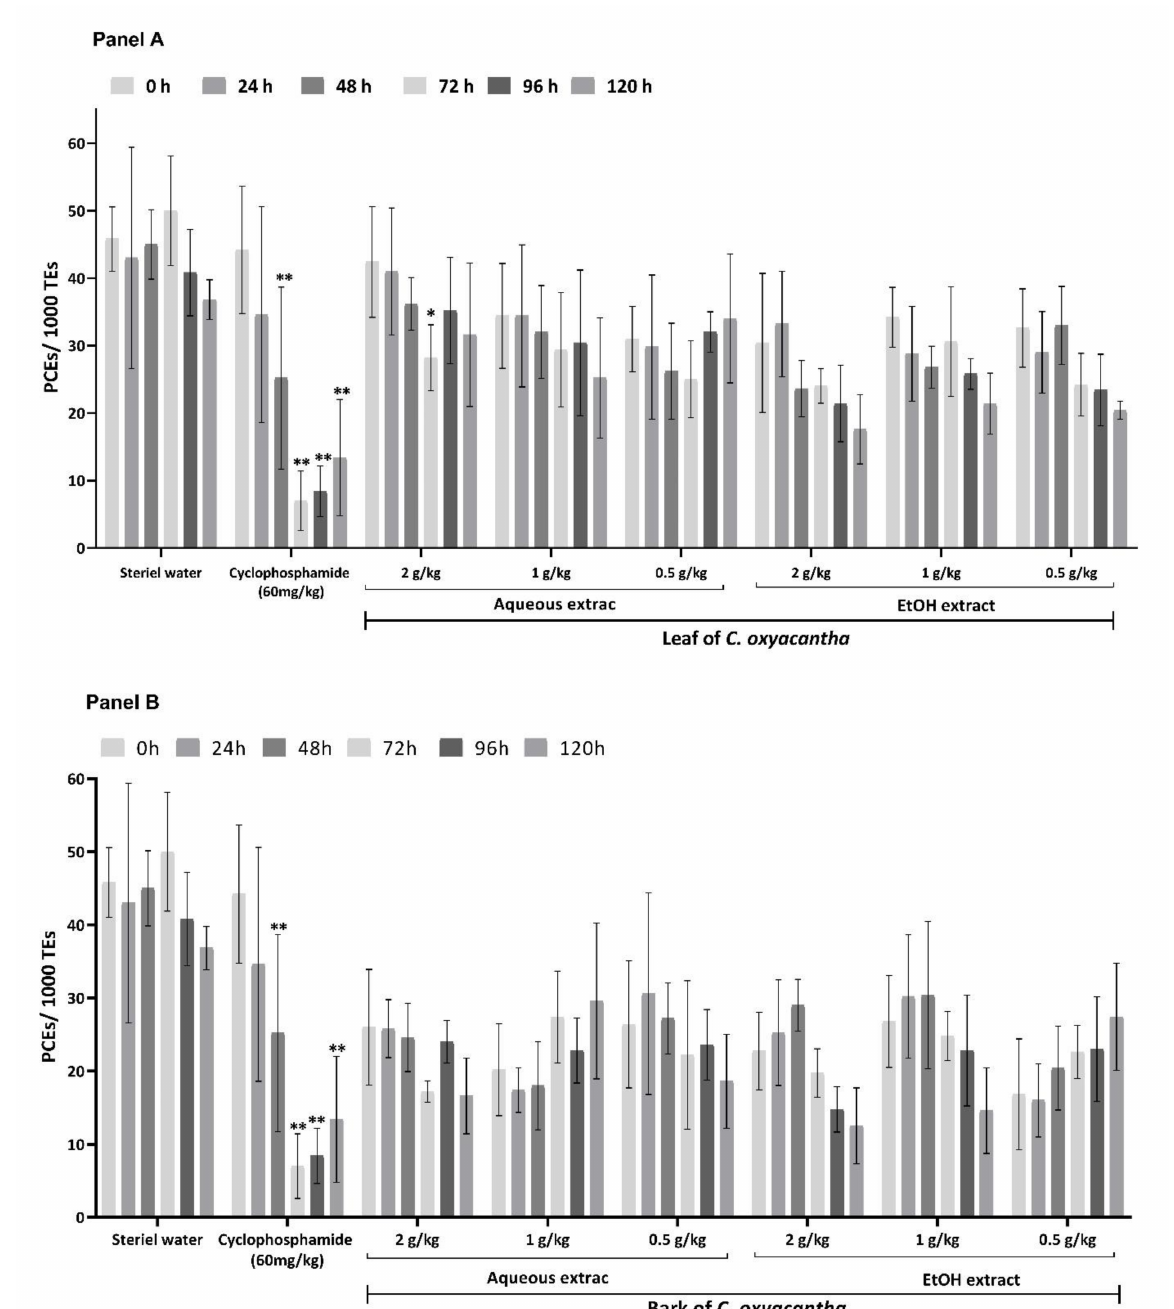
Figure 1. Proportion of PCEs in mouse peripheral blood in the study groups. Panel A shows the results obtained from the leaf and panel B those from the bark of C. oxyacantha Intragroup comparisons were performed between baseline samples (0 h) against the following sampling times: 24, 48, 72, 96, and 120 h. PCEs, Polychromatic Erythrocytes; * p < 0.05; ** p <